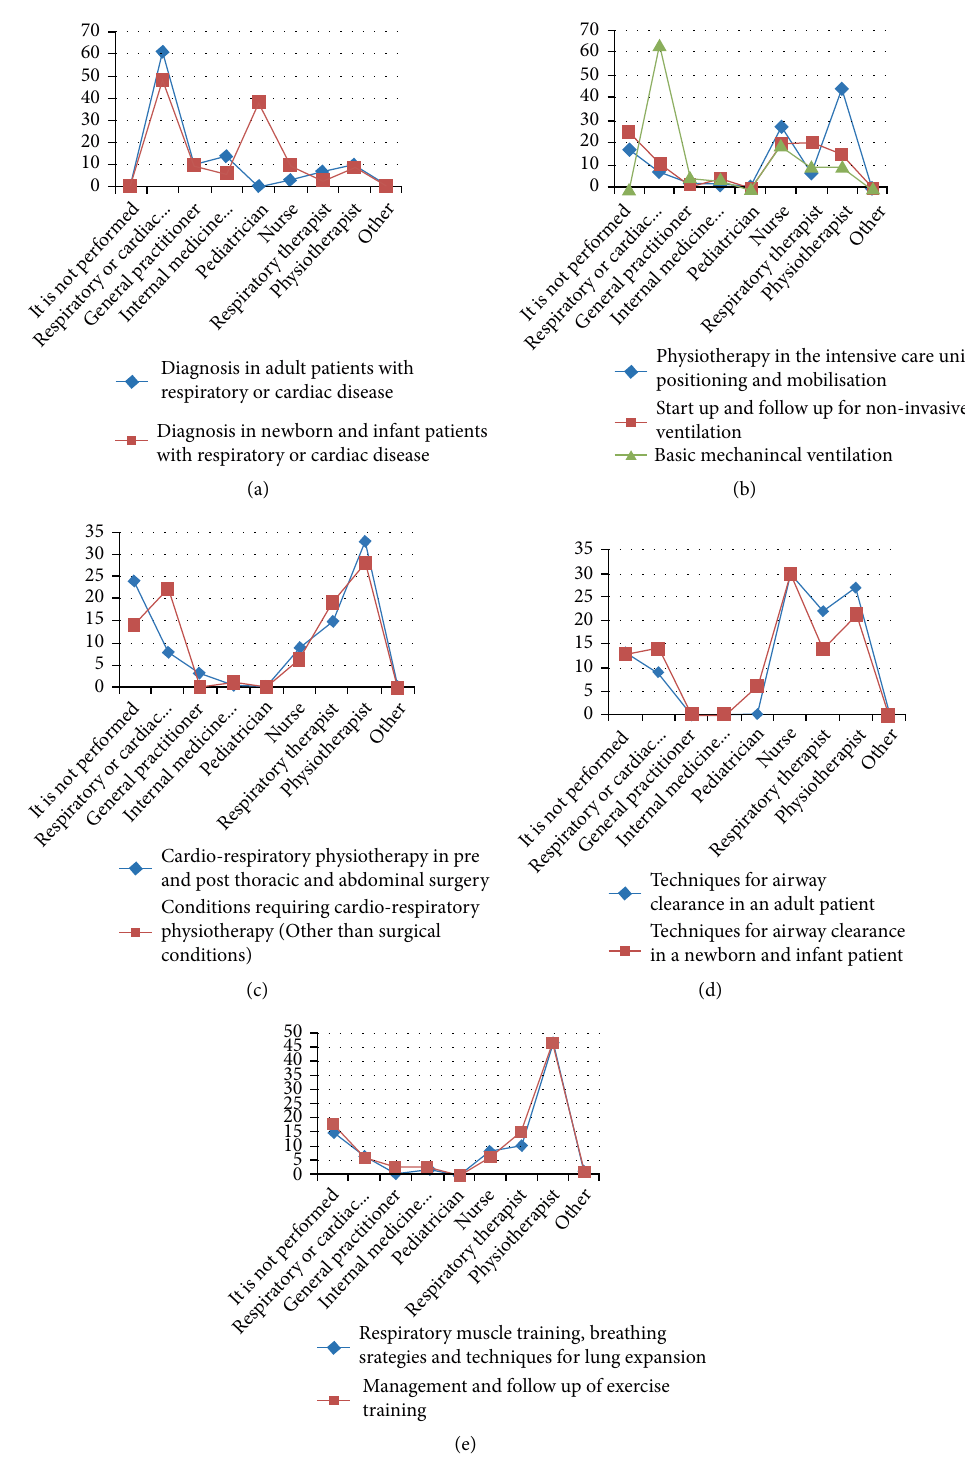
Figure 3: Distribution of clinical responsibilities. (a) Diagnosis. (b) Physiotherapy in the ICU. (c) Physiotherapy pre and post surgery. (d) Airway clearance. (e) Respiratory muscle training, breathing strategies and lung